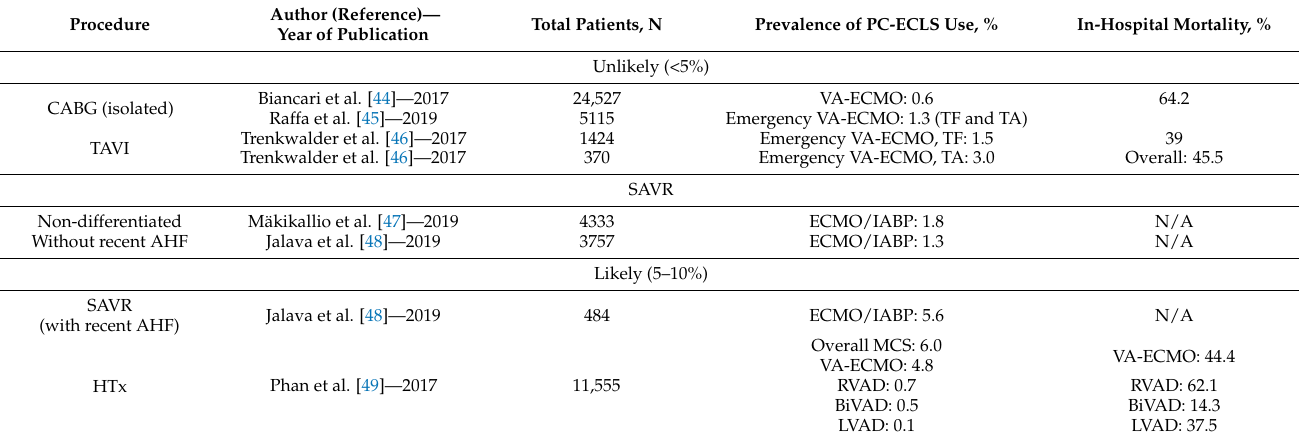
Table 3. Likelihood of PC-ECLS with regards to several surgical